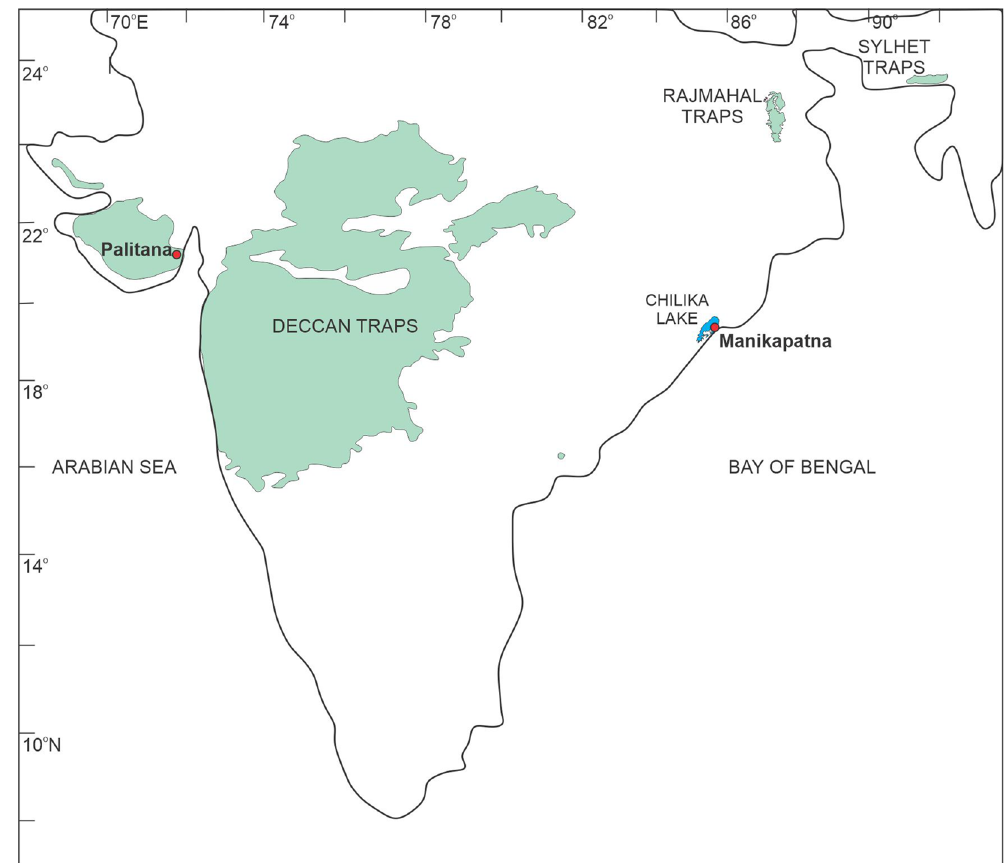
Figure 11. Map of peninsular India showing distribution of the Youngest (Cretaceous) Basaltic Volcanism in India: ~ 116 Ma Rajmahal-Sylhet Traps 35 ; ~ 66 Ma Deccan Traps 36 . Locations of the discovery site Manikapatna and the source rock locality, Palitana in Gujarat, are